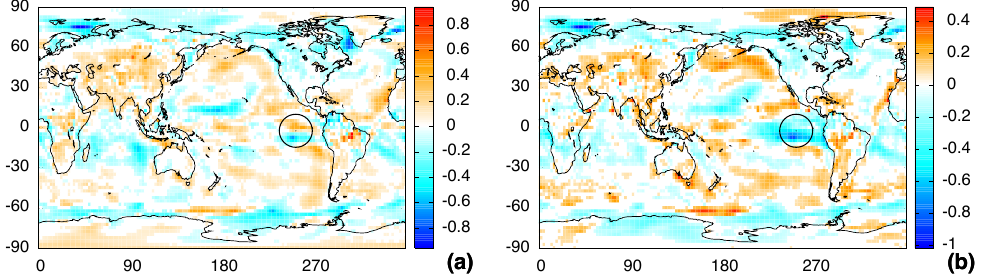
Figure 3. Relative change in amplitude fluctuations computed from the variance of the (a) Hilbert amplitude, (cid:49)σ 2 a /σ 2 a ; (b) the anomaly time series, (cid:49)σ 2 z /σ 2 z .